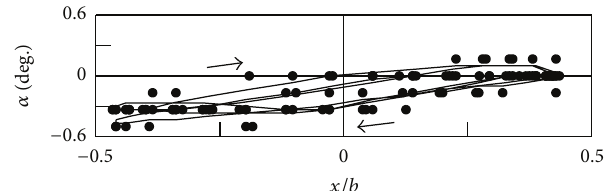
Figure 17: The angle of the body tilt during the oscillation near the cavity